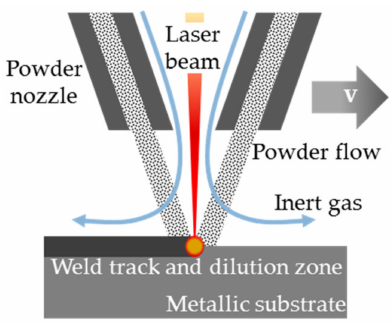
Figure 1. Schematic principle of Laser Metal Deposition (LMD). Adapted from